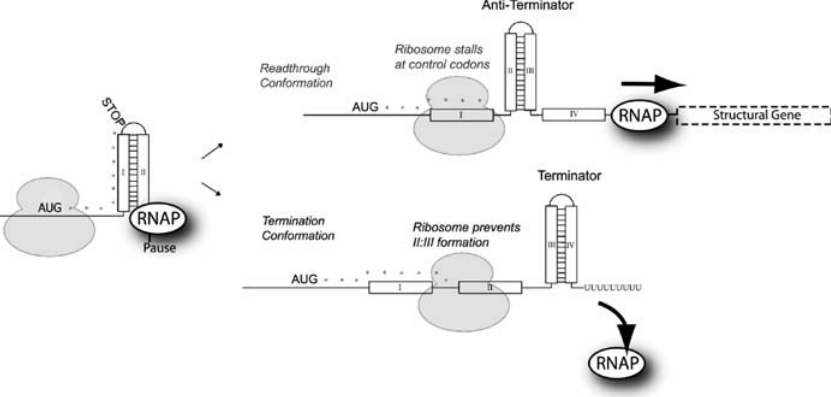
Figure 1. The Leader-Transcript of the trp Operon in E. coli Attenuated transcription results in a 141-nucleotide (nt) transcript. Aborted transcription of the paused RNAP results in a 91-nt transcript. The transcript includes an open reading frame of 15 codons, encoding a very short-lived 14-residue leader peptide. The RNAP is released from the pause site when the seventh codon is read [17]. Two of the three codons in the control region (10 and 11) are trp codons. Also, ribosome stalling on the arg -codon (12) prevents I:II -hairpin formation and attenuation (see Figure 6). After reaching the stop codon, the ribosome dissociates in about 1 s. The II:III and III:IV conformations have similar stabilities, and the terminator is formed with 50% probability when the ribosome reaches the stop codon and dissociates from the transcript before region IV is available. This determines the basal read-through level of 10–15%. DOI: